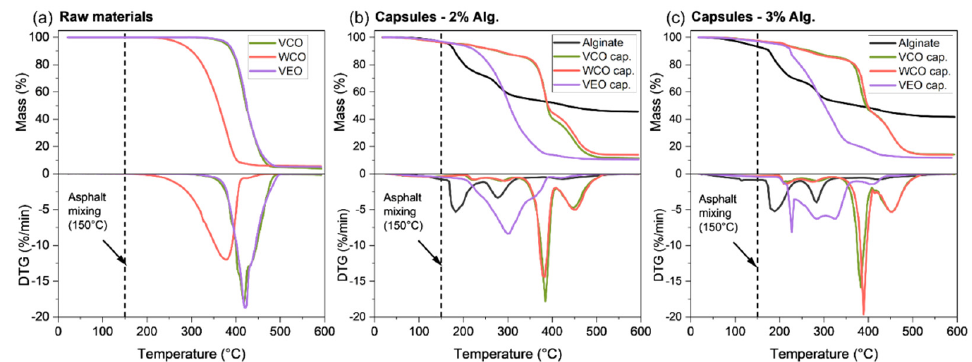
Figure 7. TGA-DTG curves for: ( a ) the VCO, WCO, and VEO; alginate matrix and capsules synthe- sised with ( b ) 2% and ( c ) 3% of alginate. sised with ( b ) 2% and ( c ) 3% of